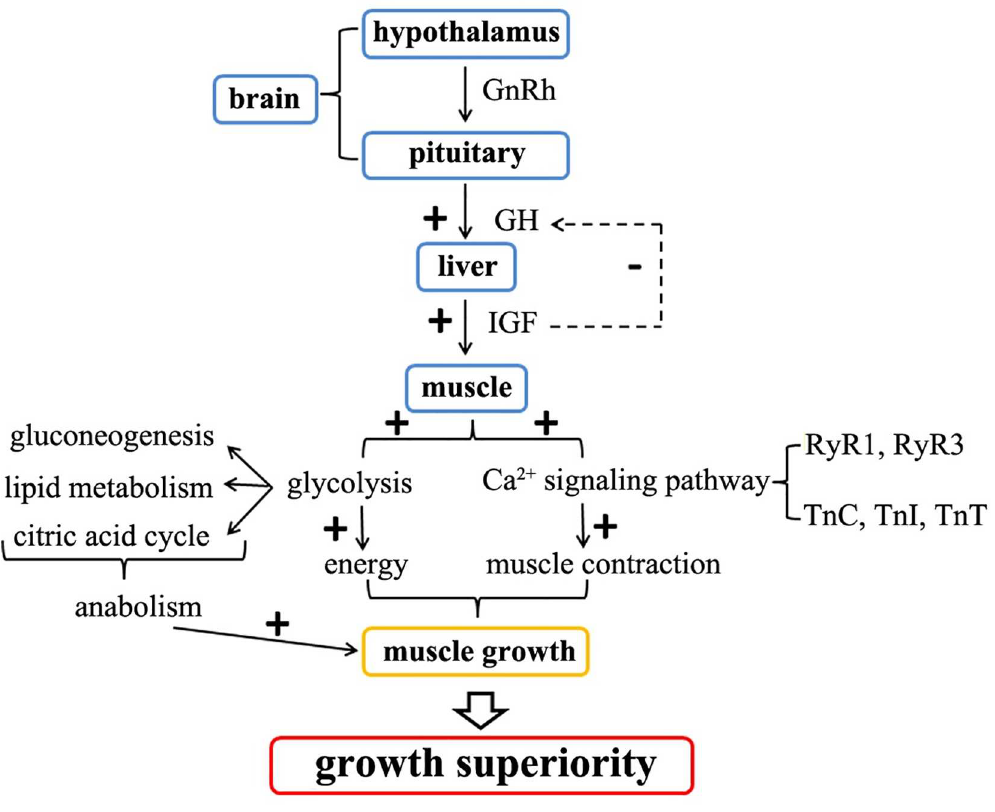
S1 Table. Sequences of specific primers for the qRT-PCR. S2 Table. RPKM values of all genes identified in the hybrid grouper and its parents. S3 Table. Differentially expressed genes in the muscle between Hyb and Efu. S4 Table. Differentially expressed genes in the muscle between Hyb and